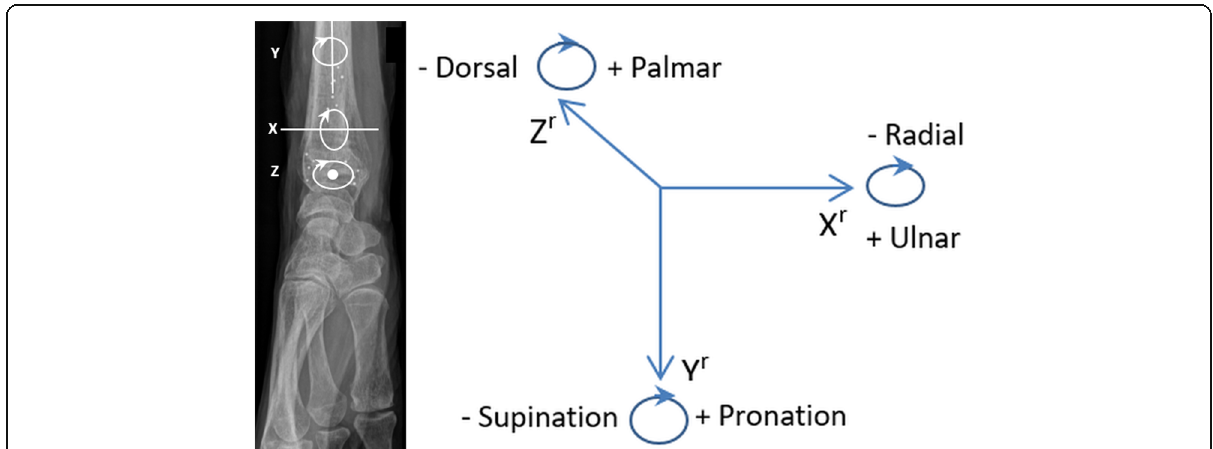
Fig. 3 Rotation ( XYZ r ) in three dimensions according to the global coordinate system (right arm). Rotation around the y -axis ( Y r ) represents supination ( − ) and pronation